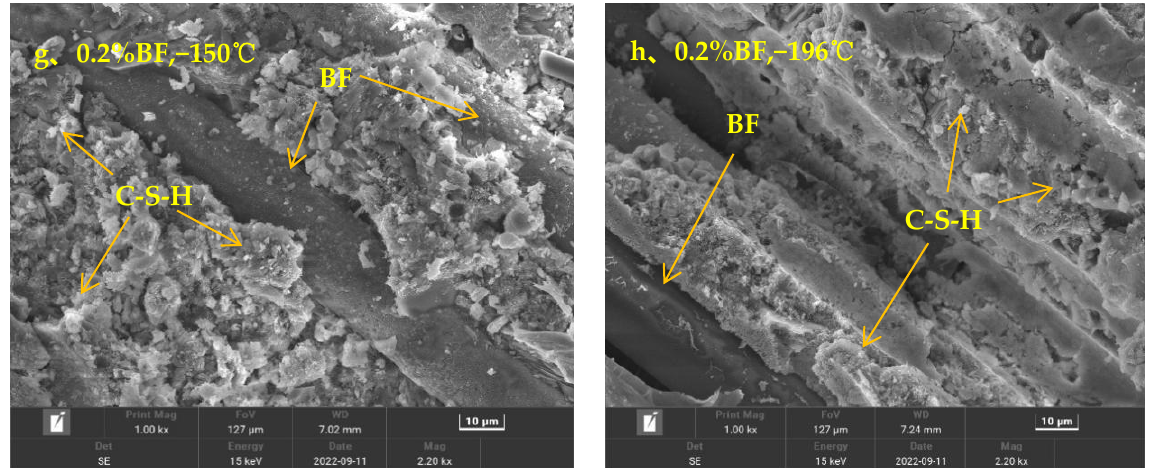
Figure 22. SEM image of basalt fiber concrete.